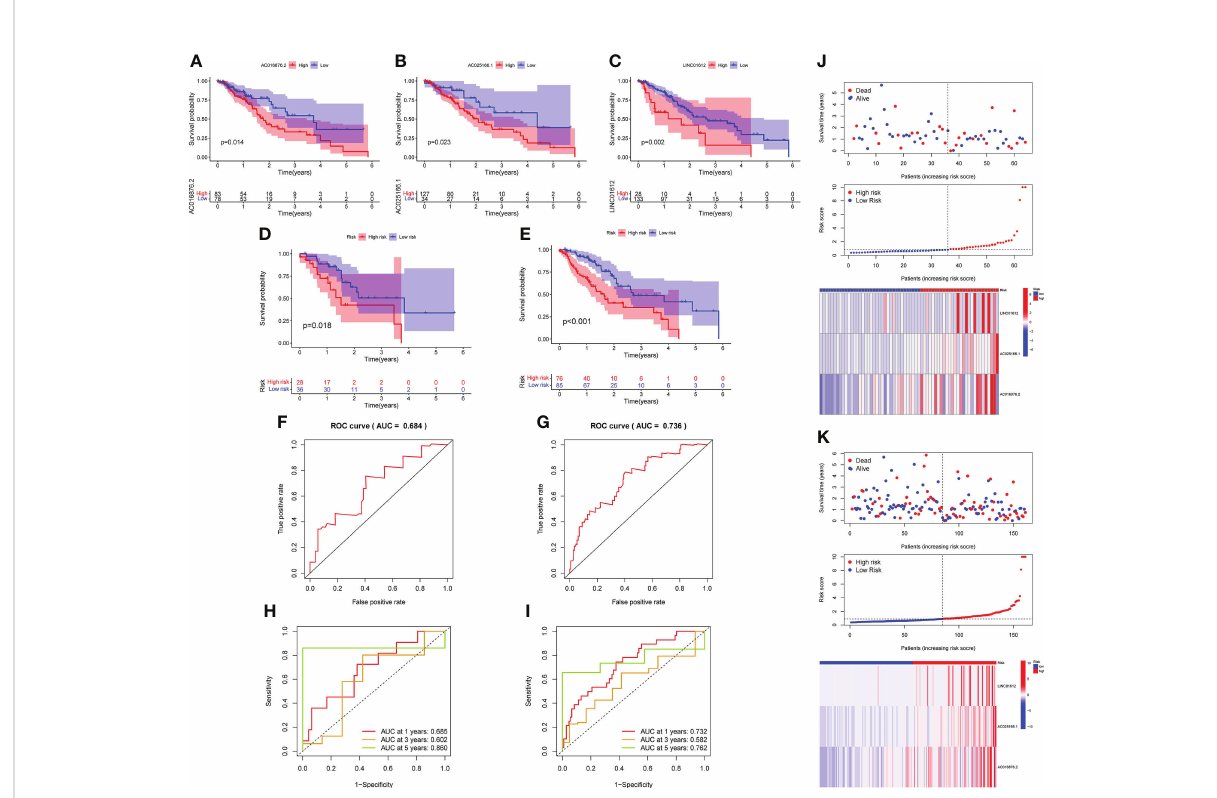
FIGURE 2 K-M survival analysis was conducted to assess the roles of the 3 lncRNAs in prognoses. (A – C) K-M survival curves demonstrated that a high level of LINC01612, AC025166.1 and AC016876.2 expression was associated with worse OS in the training set (p< 0.05), validation of the prognostic risk model according to 3 m6A-associated lncRNAs in the testing and complete sets. (D, E) K-M survival curves indicated that a subgroup of EC patients at low risk possessed a better OS in the testing and complete sets. (F, G) The prognostic risk model was able to predict the outcome using ROC curves in the testing set and complete set. (H, I) An analysis of ROC curves was carried out to determine the prognostic risk model ’ s predictive effectiveness for survival rates at 1, 3, and 5 years in the testing and complete sets. (J, K) Survival status scatter plot, risk score distribution and heatmap of the expression pro fi les three m6A-associated lncRNAs in the testing and complete